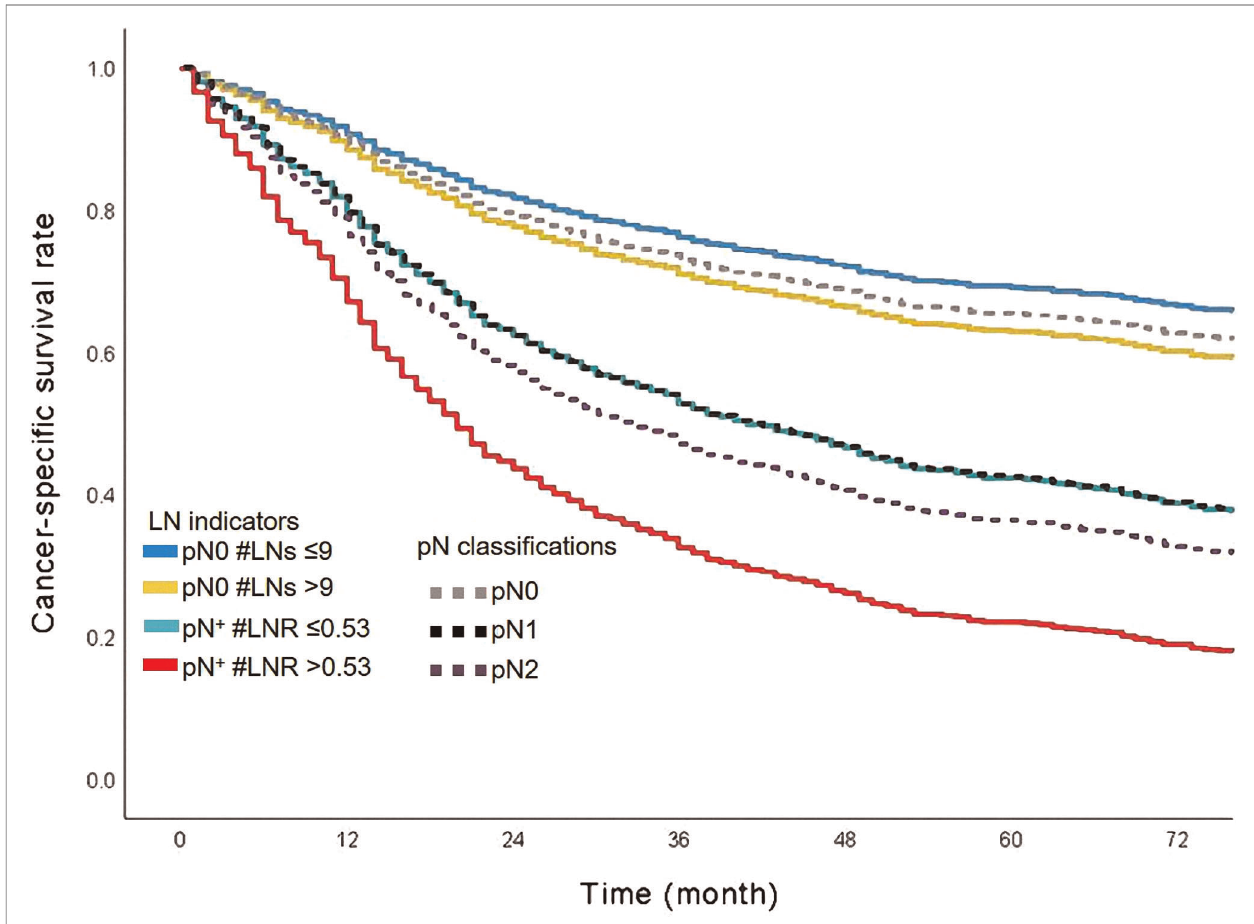
FIGURE 4 | The combined survival curves based on pN classi fi cation and LN indicator. LN, lymph